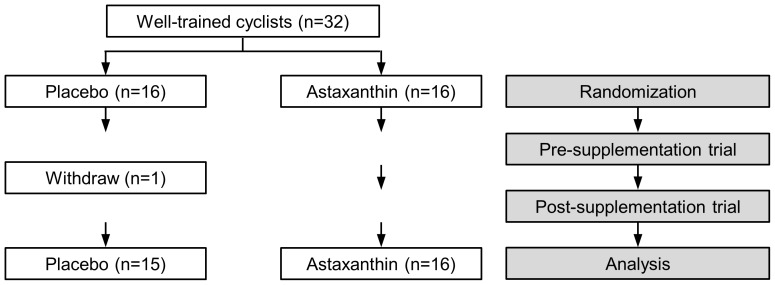
Flow chart of the trial.